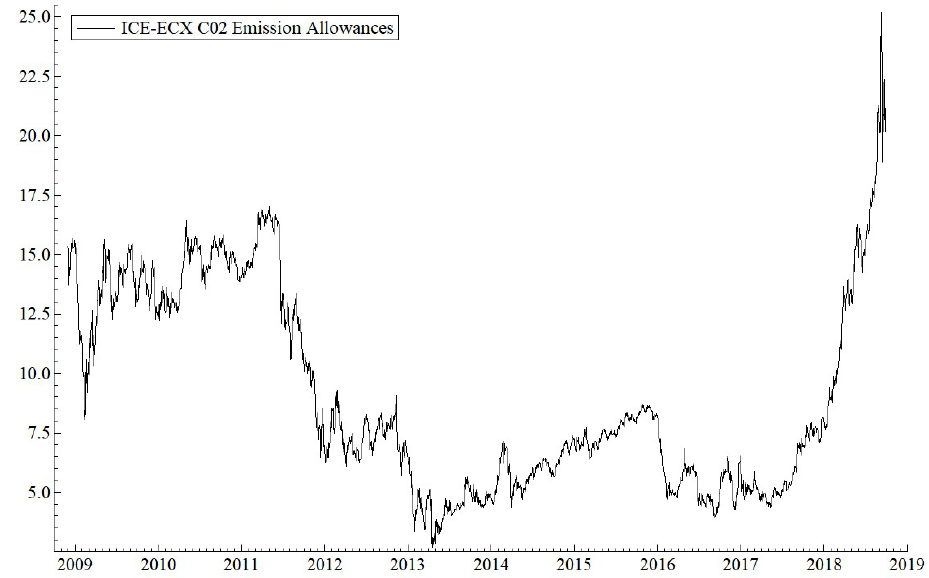
Figure 3. Daily future prices for (Intercontinental Exchange Futures Europe (ICE-ECX)) carbon emission allowances in Euro/ton, 2 December 2008 to 28 September 2018.